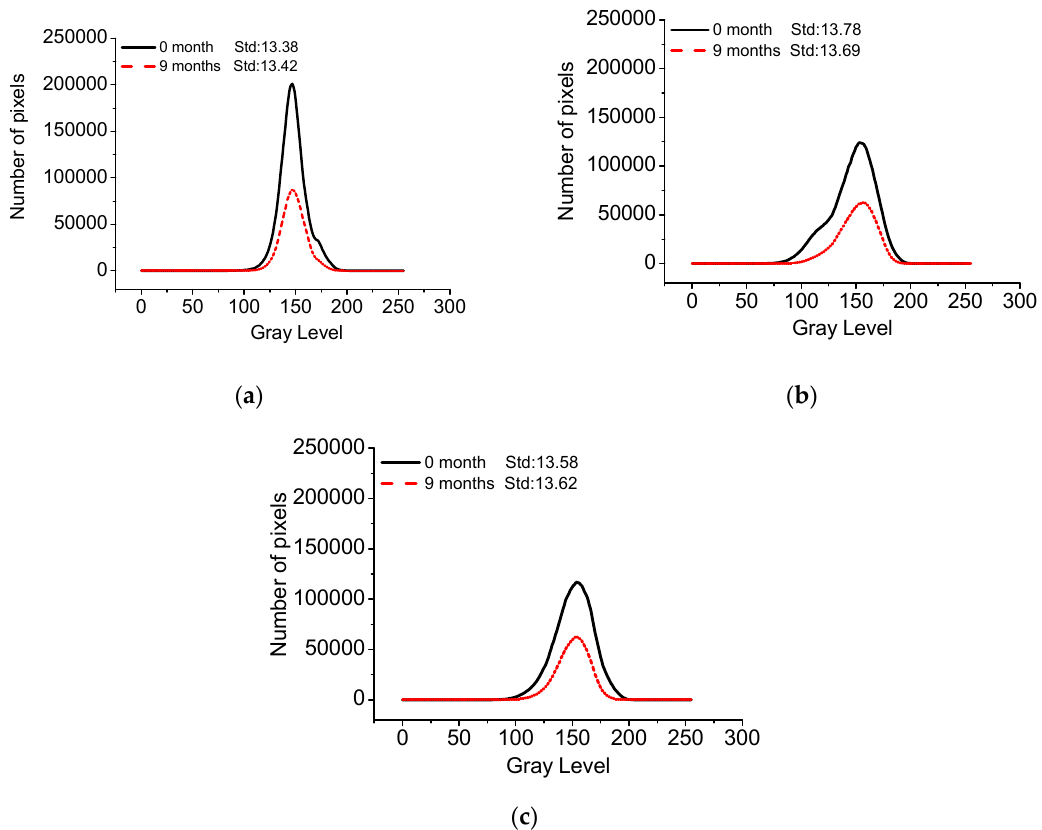
Figure 20. Gray of C40, C50, and C55 exposed to the atmosphere zone after different exposure times. ( a ) C40. ( b ) C50. ( c ) C55.